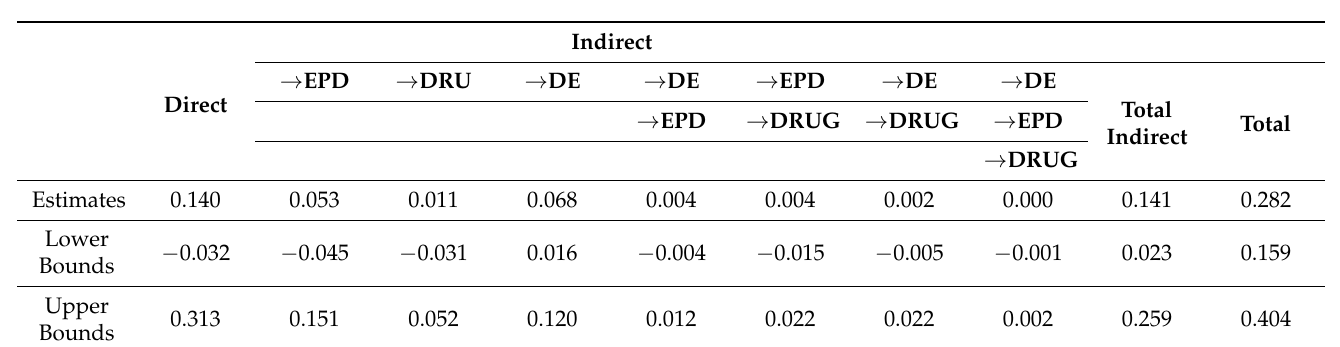
Table 3. Direct and Specific Indirect Associations between Exposure to Community Violence and Bullying